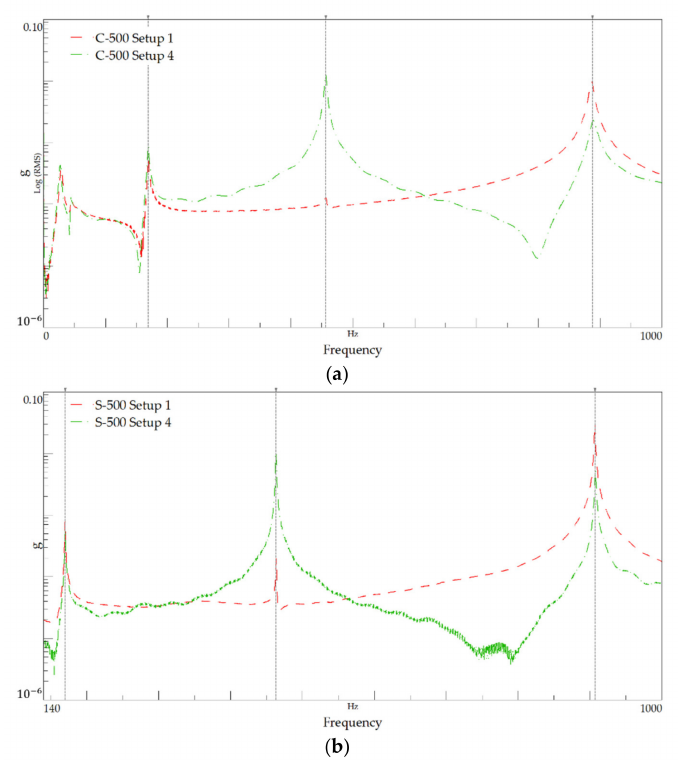
Figure 13. Power spectral density plot for the 500 mm-length: ( a ) C-500 and ( b ) S-500.